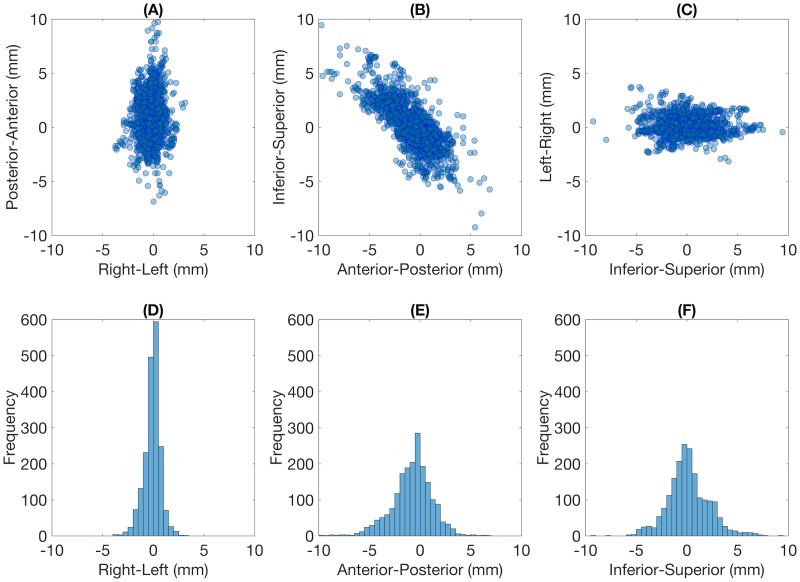
Characteristics of intra-fraction prostate motion for 1929 timestamps.Two-dimensional scatter plots in the (A) axial, (B) sagittal, and (C) coronal planes, and histograms in the (D) right-left, (E) anterior-posterior, and (F) inferior-superior directions. The width of bins was 0.5 mm.